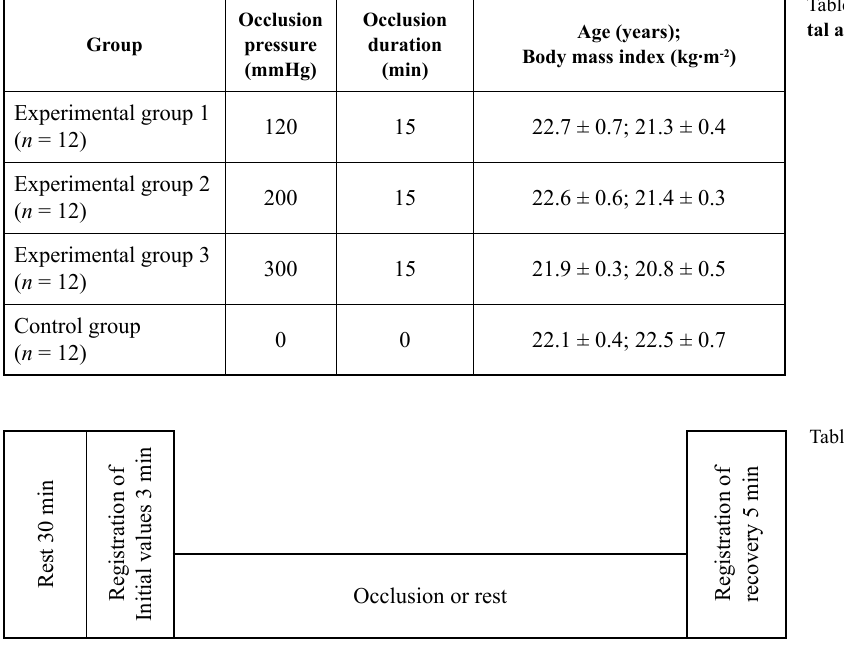
Table 1. Characteristics of the experimen- tal and control groups